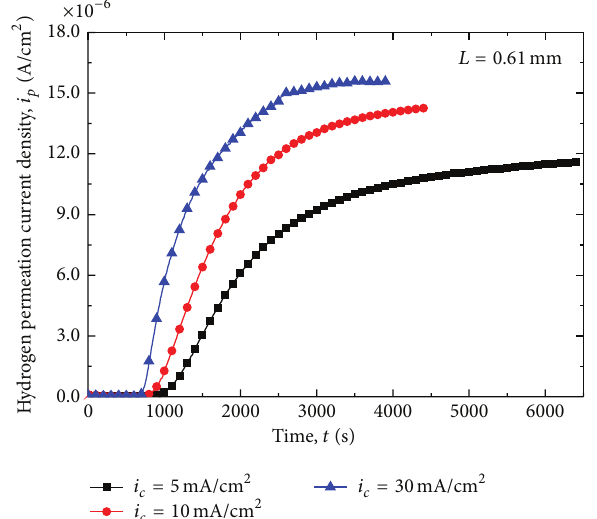
Figure 2: Hydrogen permeation curves for the silicon steel with the same thickness under different hydrogen charging current density.